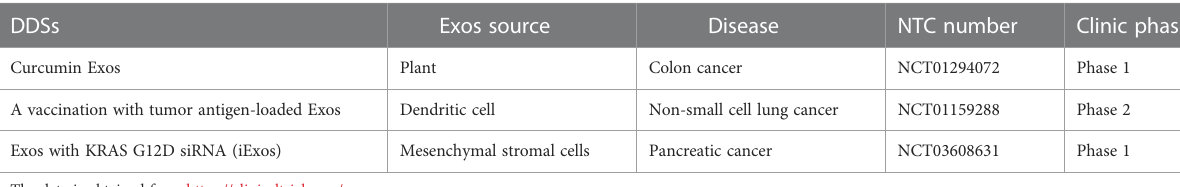
TABLE 3 The current clinical trials of Exos as drug delivery